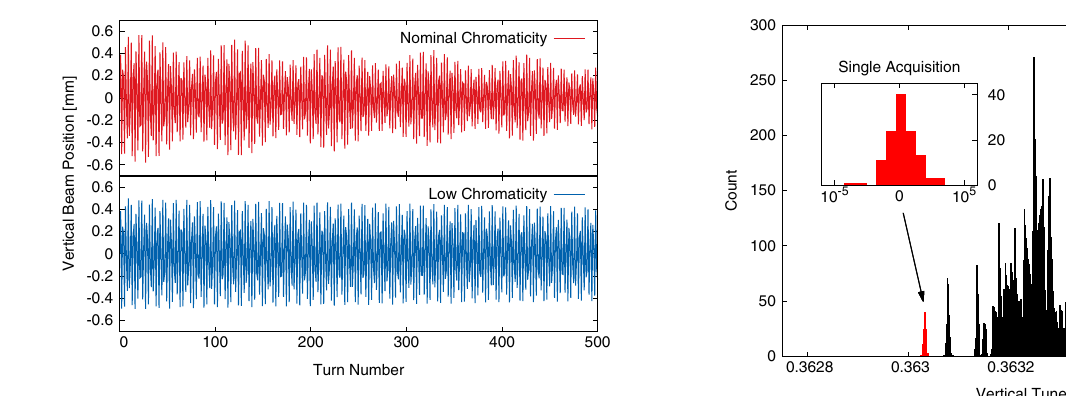
FIG. 3. Histogram of the vertical tune measured by 120 BPMs for 100 acquisitions. The measurement shows an overall standard deviation of 1 . 1 × 10 − 4 , on the other hand looking at one single acquisition (in red) the spread is strongly reduced presenting a standard deviation of only 2 . 1 × 10 − 6